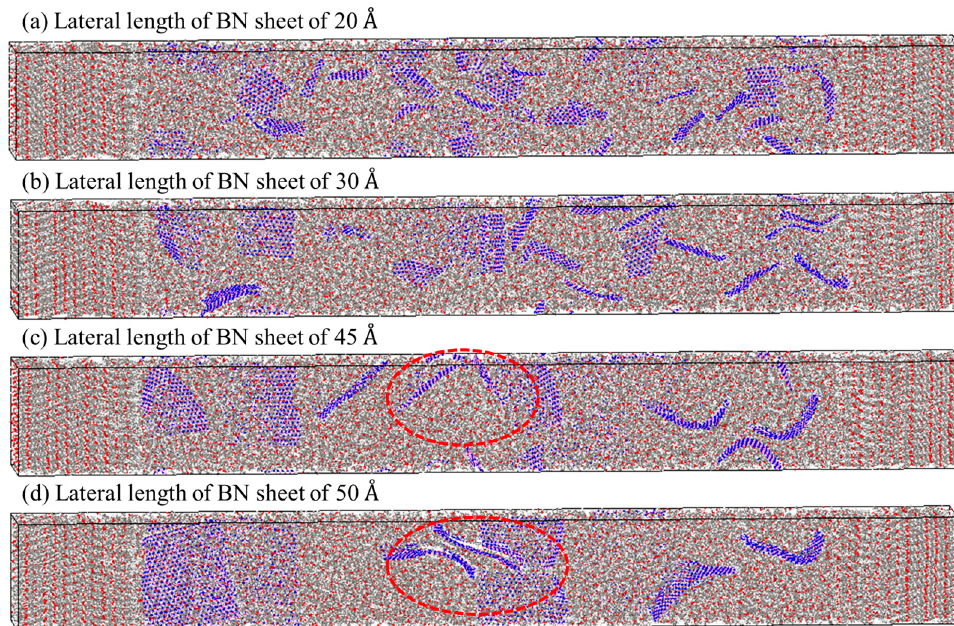
Figure 8. Equilibrium structure according to the lateral length of square BN sheets in PEEK/BN composites: ( a ) 20 Å (well-dispersed BN sheets), ( b ) 30 Å, ( c ) 45 Å, and ( d ) 50 Å (aggregated BN sheets as shown in the dotted red circle).